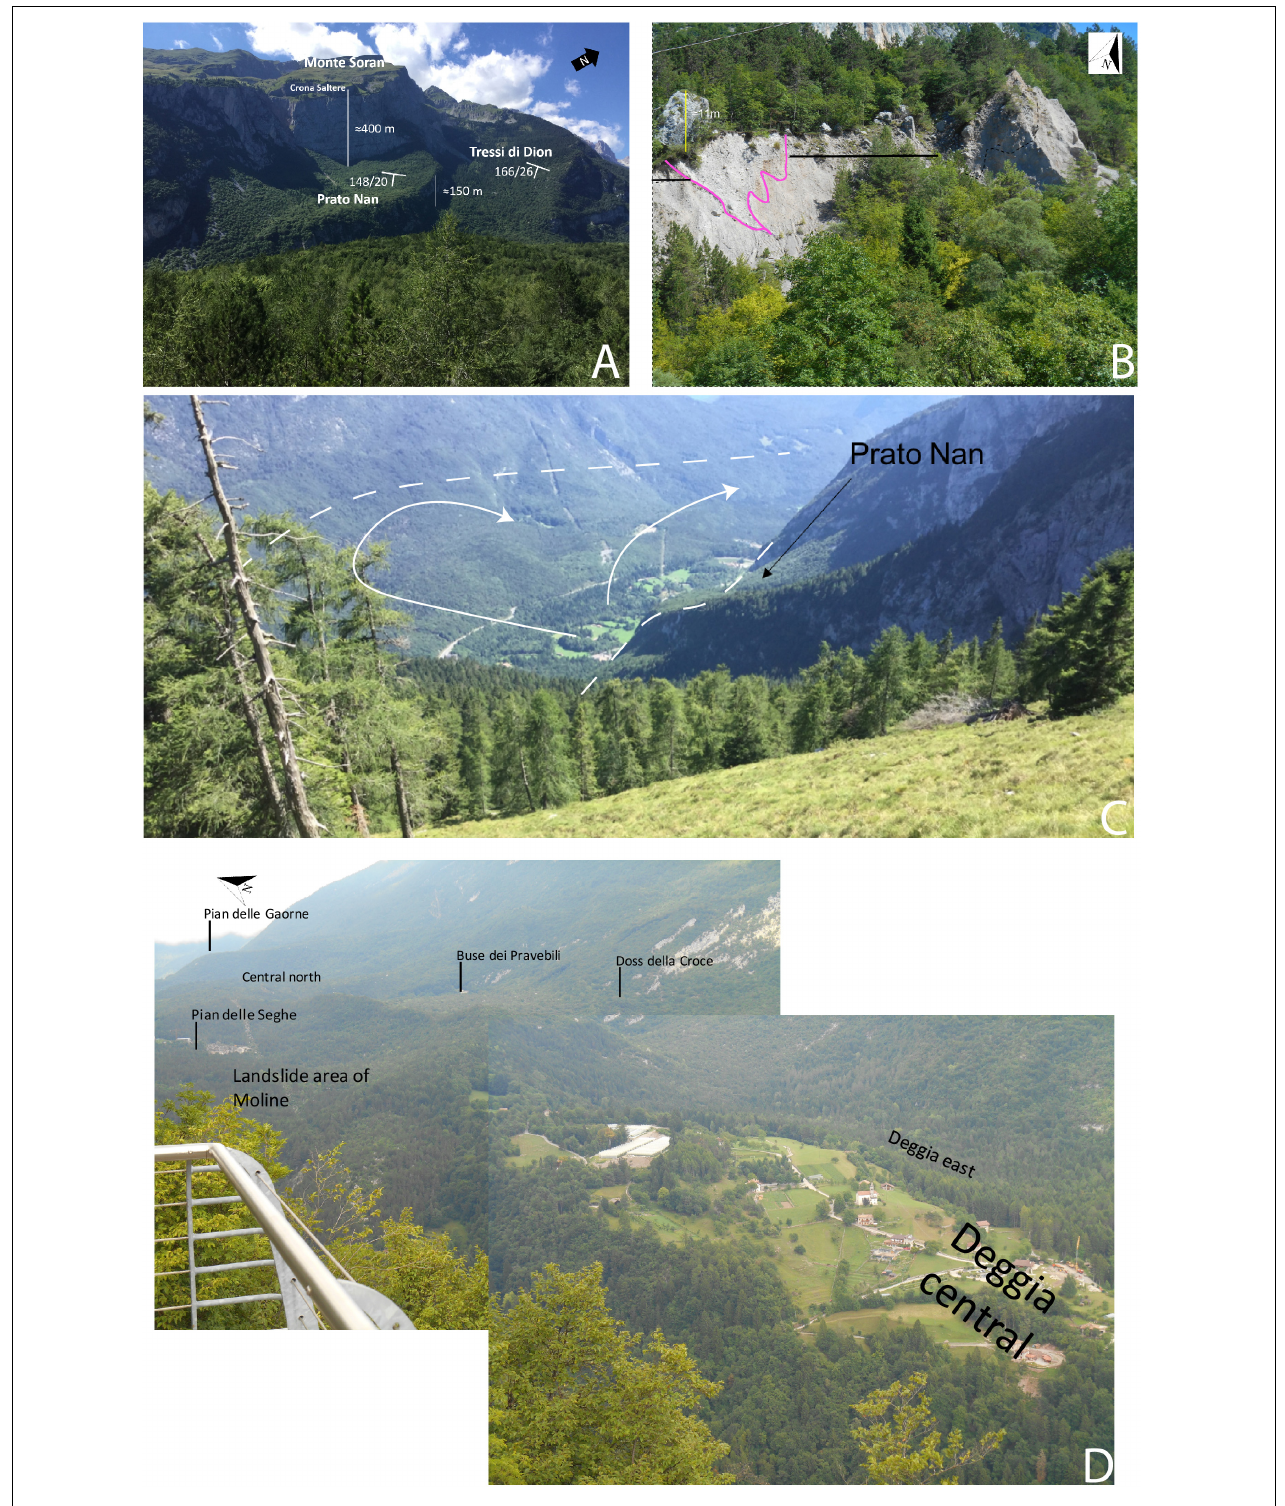
FIGURE 3 | (A) Image of rupture surface, showing both Prato Nan, and Tressi di Dion. (B) Outcrop of landslide deposits at Moline. Typical example of a carapace (large boulders on top) and strongly comminuted material inside the deposits. The carapace layer is indicated with a black line. The purple line shows a wedge-shaped pattern of coarser looking material. The boulder on top is around 11 m high (Photo: S. Ivy-Ochs). (C) Overview of the landslide looking from Tressi di Dion toward Pian delle Gaorne. (D) Overview of deposit zones.